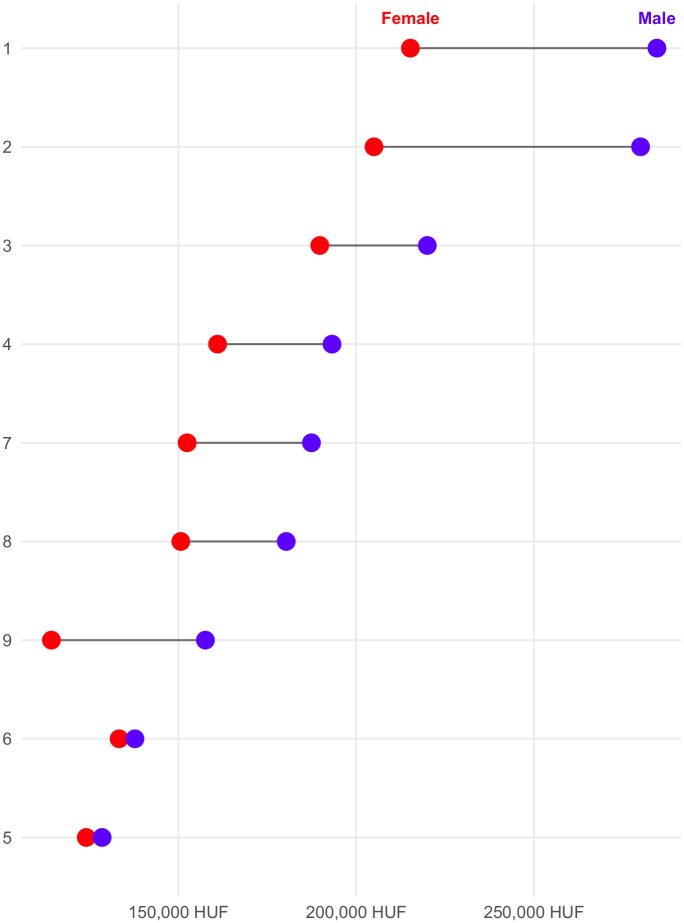
Gender pay gap grouped by occupations (first level ISCO).